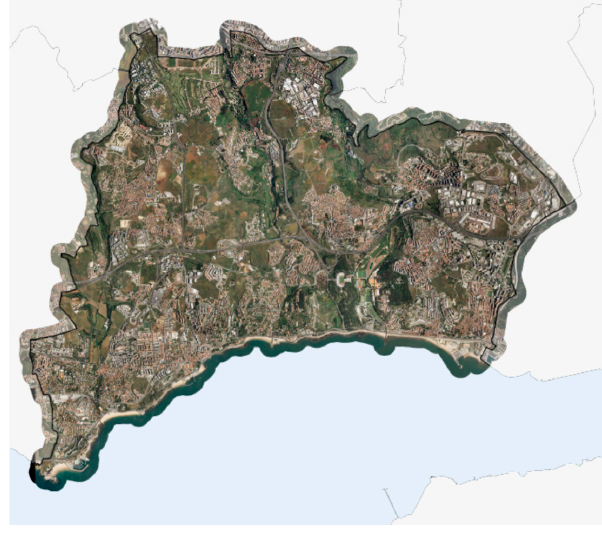
Figure 2. Orthophoto map.